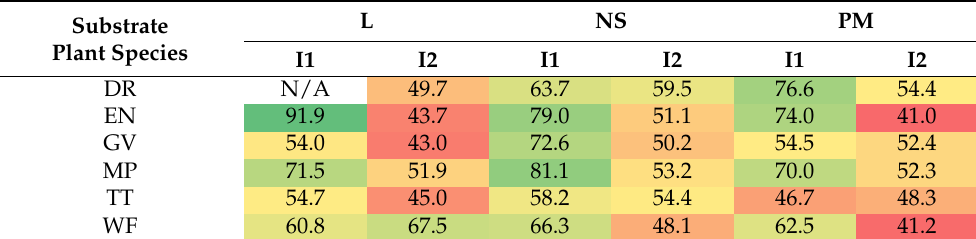
Table 3. Average relative ET rate for plant–substrate–irrigation treatments with ET from the weather station, in mL per mm of ET per